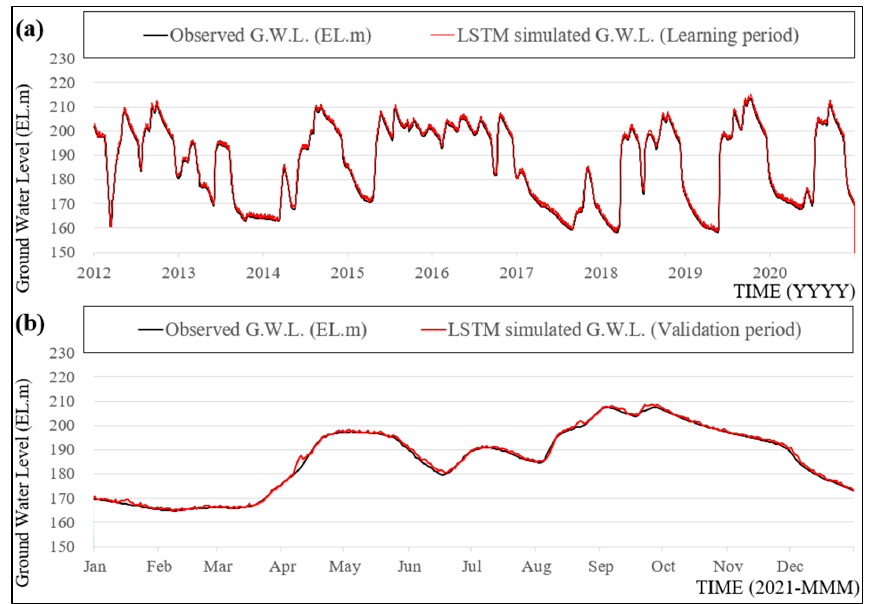
Figure 5. LSTM and ANN simulated results of GWL on Gyorae-1 at daily scale: ( a ) learning period (2012–2020) and ( b ) validation period (2021).